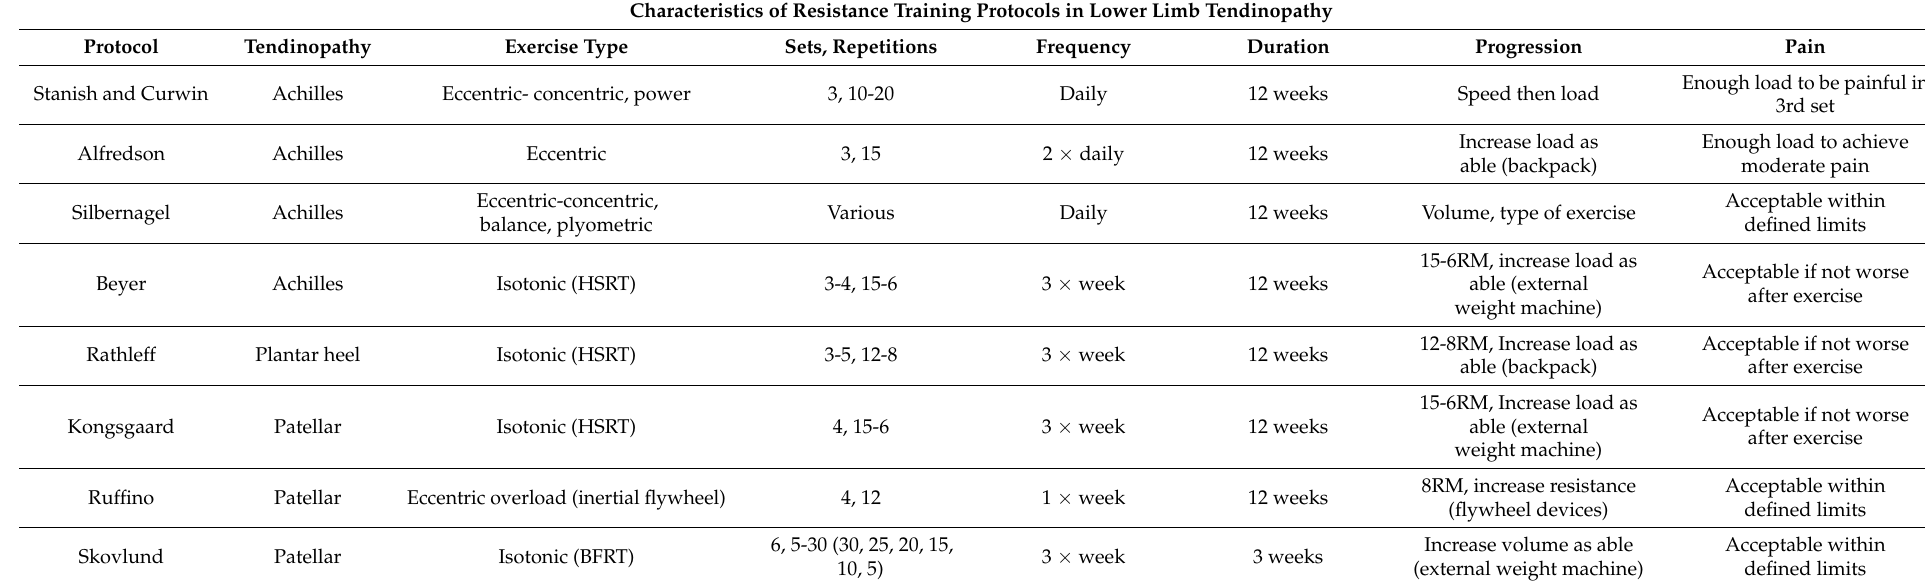
Table 5. Resistance training protocols in lower limb